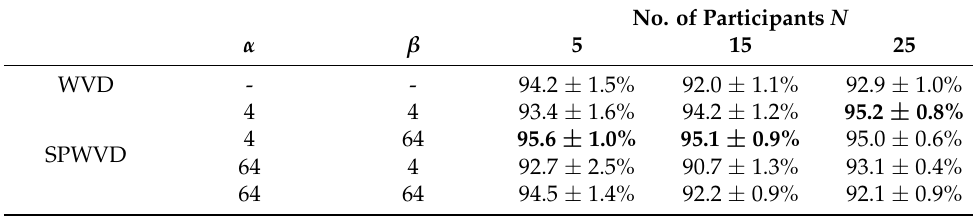
Table 3. Results for WVD and